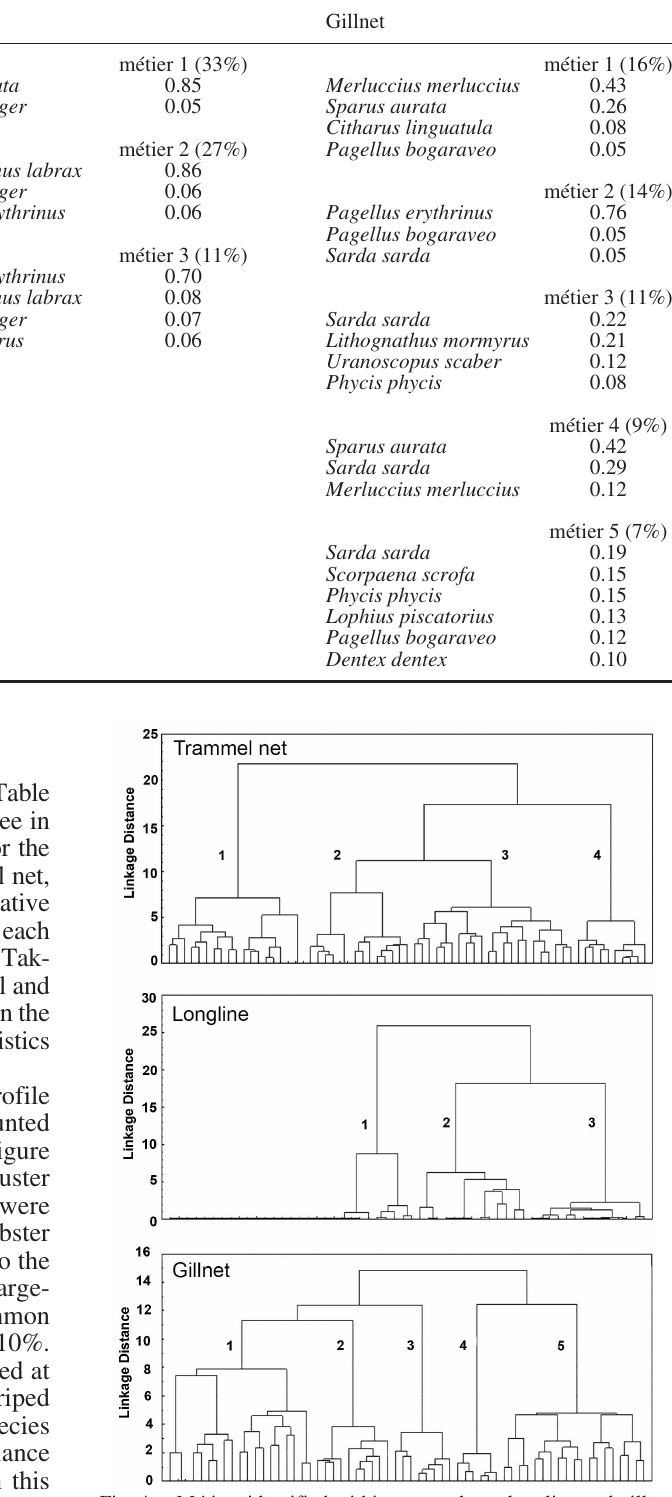
Fig. 4. – Métiers identified within trammel net, longline and gillnet through cluster analysis applied to the log-transformed landing pro- file matrices using Ward’s minimum variance clustering algorithm and the Euclidean